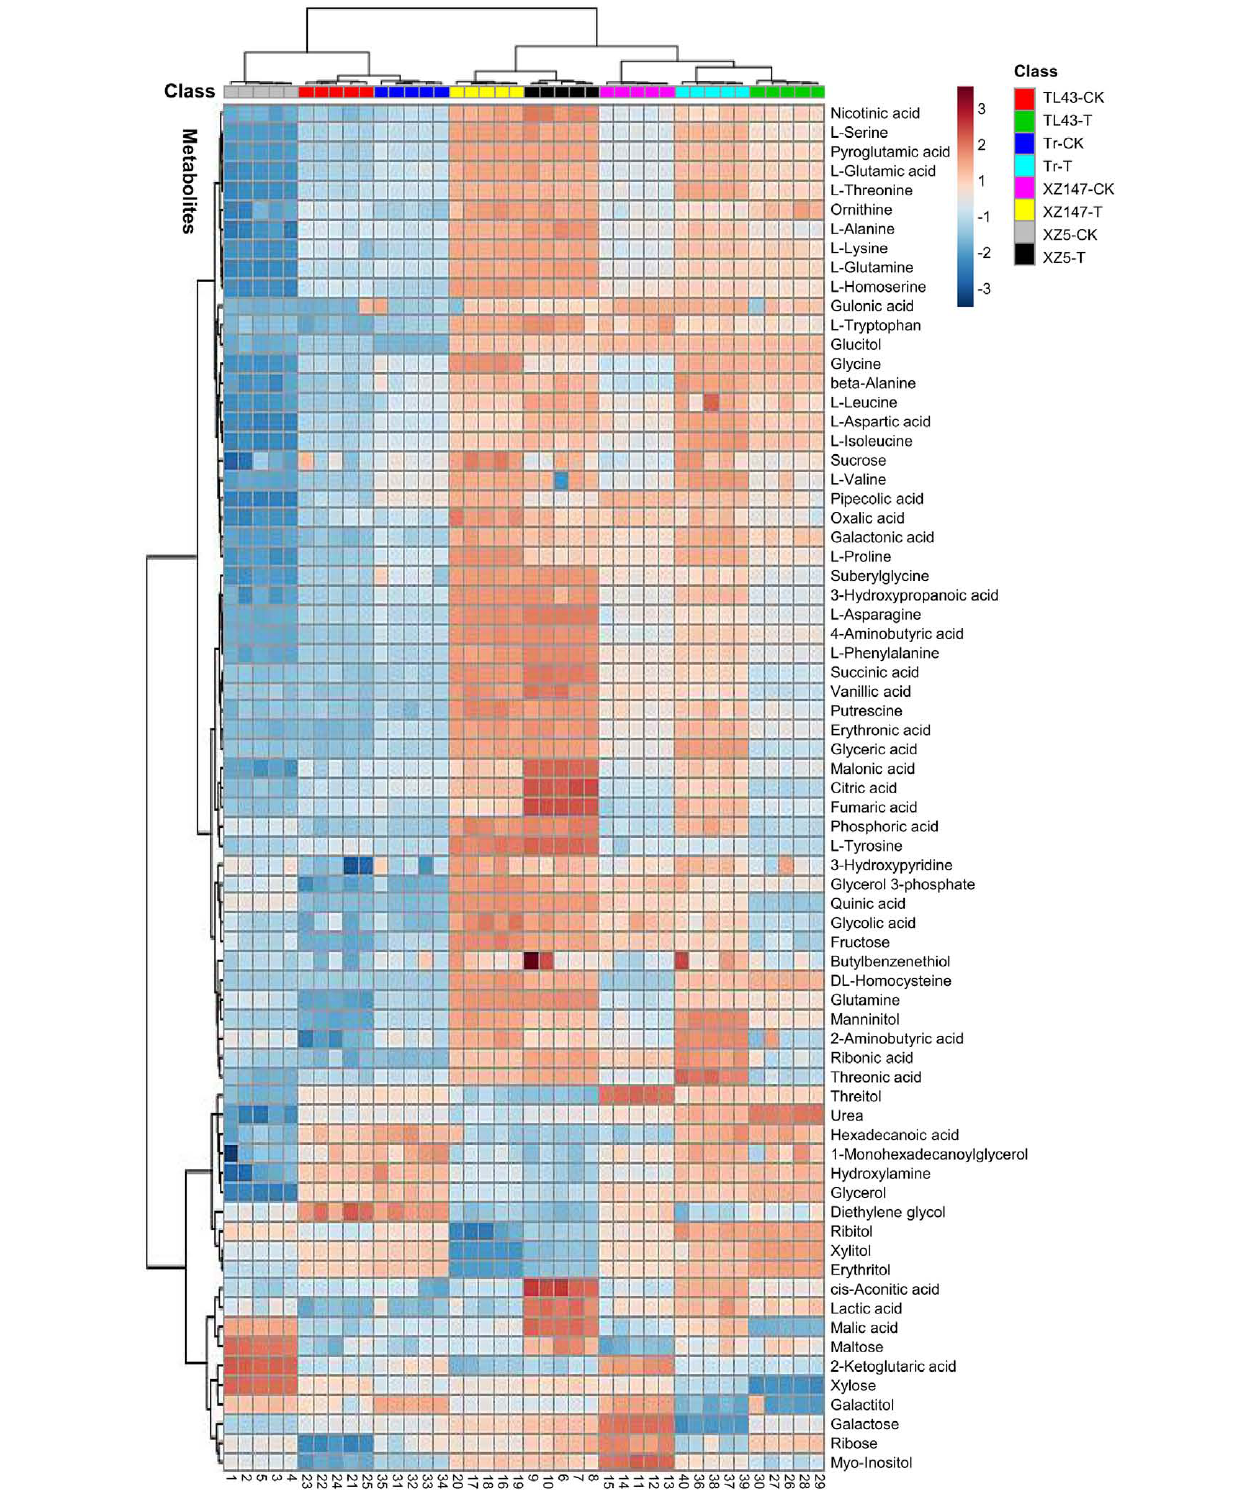
FIGURE 2 | Hierarchical cluster analysis of 71 metabolites and 8 genotype × treatment combinations (distance measure using Euclidean and clustering algorithm using Ward.D). CK, control condition with soil water content of 40%; T, water stress treatment with soil water content of 14% and Tr, Triumph. The scale –3 (dark blue, the lowest) to 3 (dark red, the highest) indicated the relative content of each metabolite for each genotype × treatment combination.